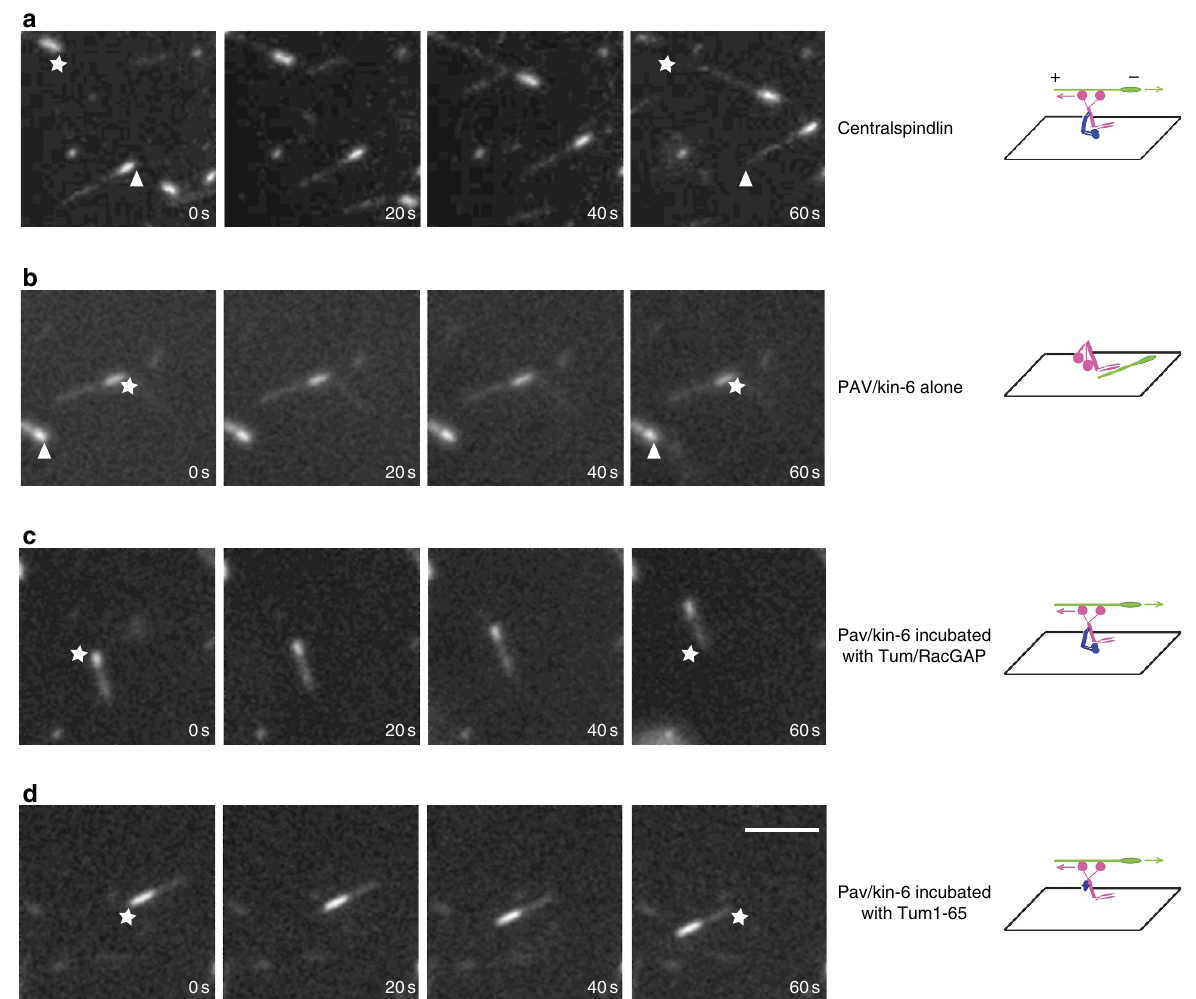
Figure 3 | MTgliding assays reveal Tum/RacGAP is required for the motor activity of Pav/kinesin-6. Assays of MTgliding driven by ( a ) centralspindlin, ( b ) Pav/kinesin-6, ( c ) Pav/kinesin-6 incubated in vitro with Tum/RacGAP, ( d ) Pav/kinesin-6 incubated in vitro with Tum1–65 fragment. In each row of panels, stars and arrowheads are positioned in the same spot to judge movement. Polarity and direction of movement is indicated by a brighter minus-end. Scale bar, 5 m